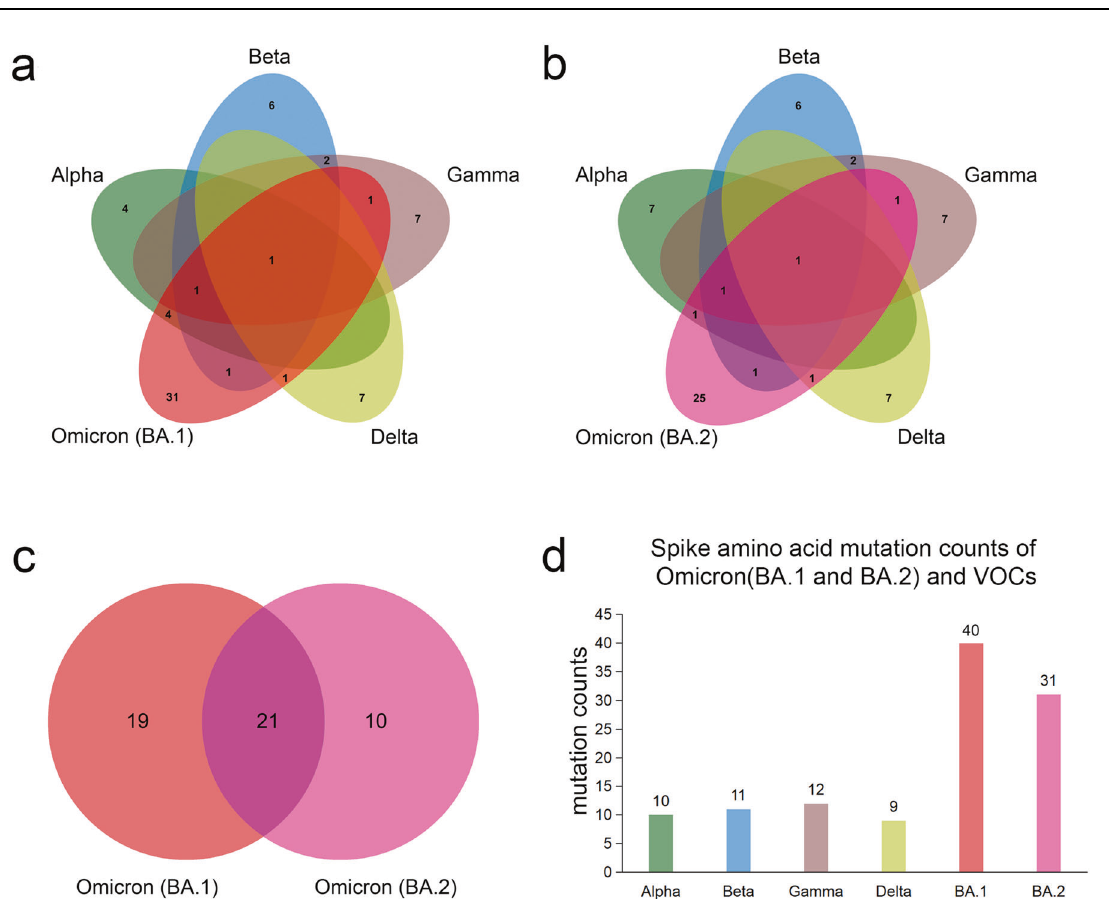
Fig. 1 Spike protein amino acid mutations of the Omicron subvariants (BA.1 and BA.2) compared with mutations from the other four variants of concern (VOCs). a Venn diagram noting mutations of Omicron (BA.1) and those of VOCs. b Venn diagram of Omicron (BA.2) mutations compared to ones of VOCs. c Venn diagram of mutations between Omicron (BA.1) and Omicron (BA.2). d Spike protein amino acid mutation counts of Omicron subvariants (BA.1 and BA.2) compared with mutations of (detailed mutations de fi ning each haplotype are listed in Supplementary Table 1). Multiple nucleotide mutations were detected in the haplotypes compared with BA.1, e.g., haplotype 19 and the revertant subgroup (H30, 32, and 43, etc.) and BA.2. The S:L452R subgroup ( “ Deltacron ” -like Variants) consists of different haplotypes with multiple nucleotide substitutions, indicating a possibly separate origin of S:L452R haplotypes or prior recombination events. recombination between Omicron and Delta variants, gaining the